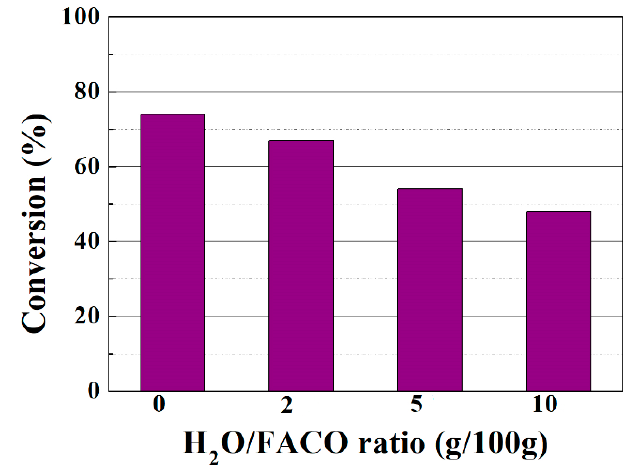
Figure 8. Influence of the H 2 O to FACO ratio (g/100 g) on the FACO to esters conversion in the esterification reaction of FACO with EH. Catalytic conditions: EH:FACO molar ratio of 1.5, reaction temperature: 50 °C, reaction time: 6 h, catalyst to FACO ratio: 6 g/100 g.